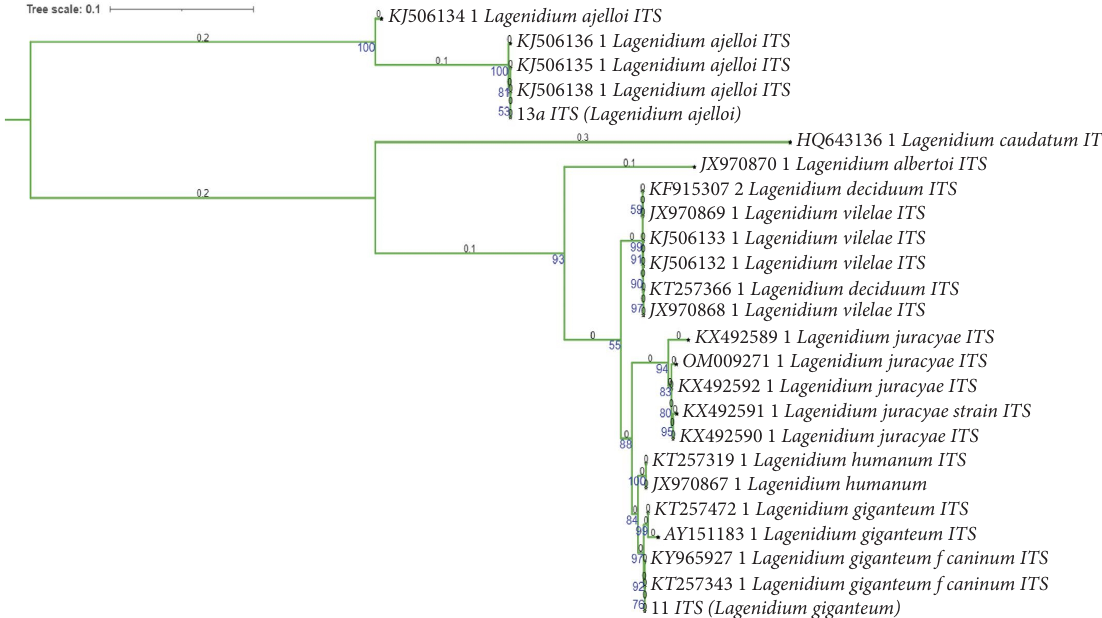
Figure 3: Phylogenetic tree of Lagenidium species.